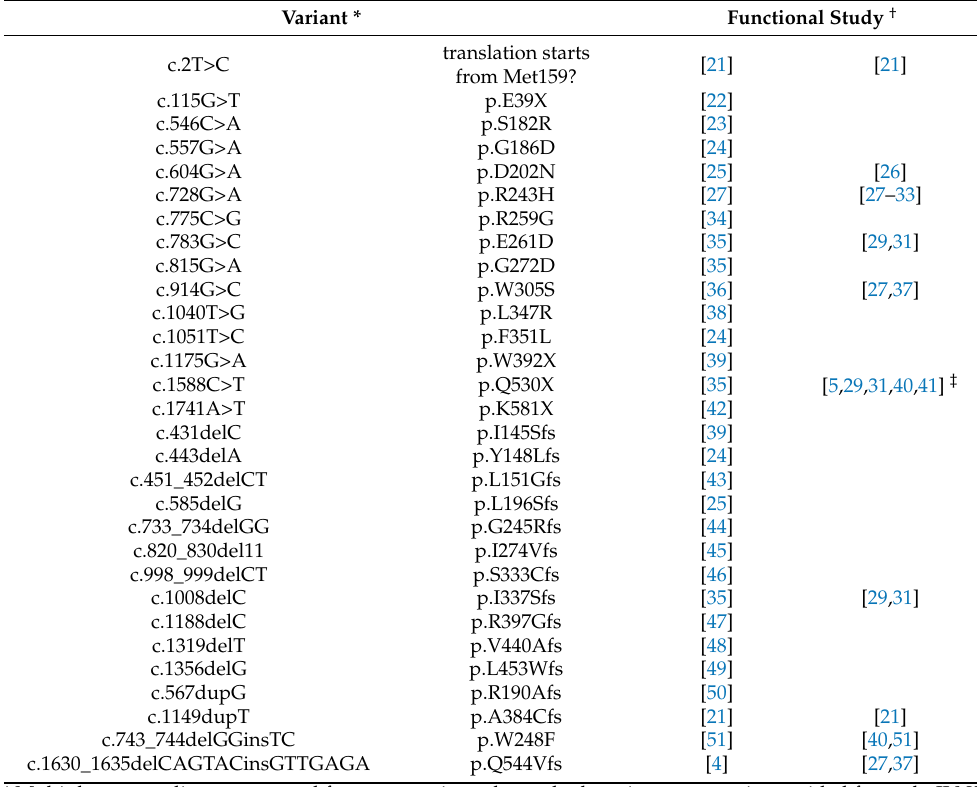
Table 1. JLNS-associated KCNQ1 variants that affect the amino acid sequence of the Kv7.1